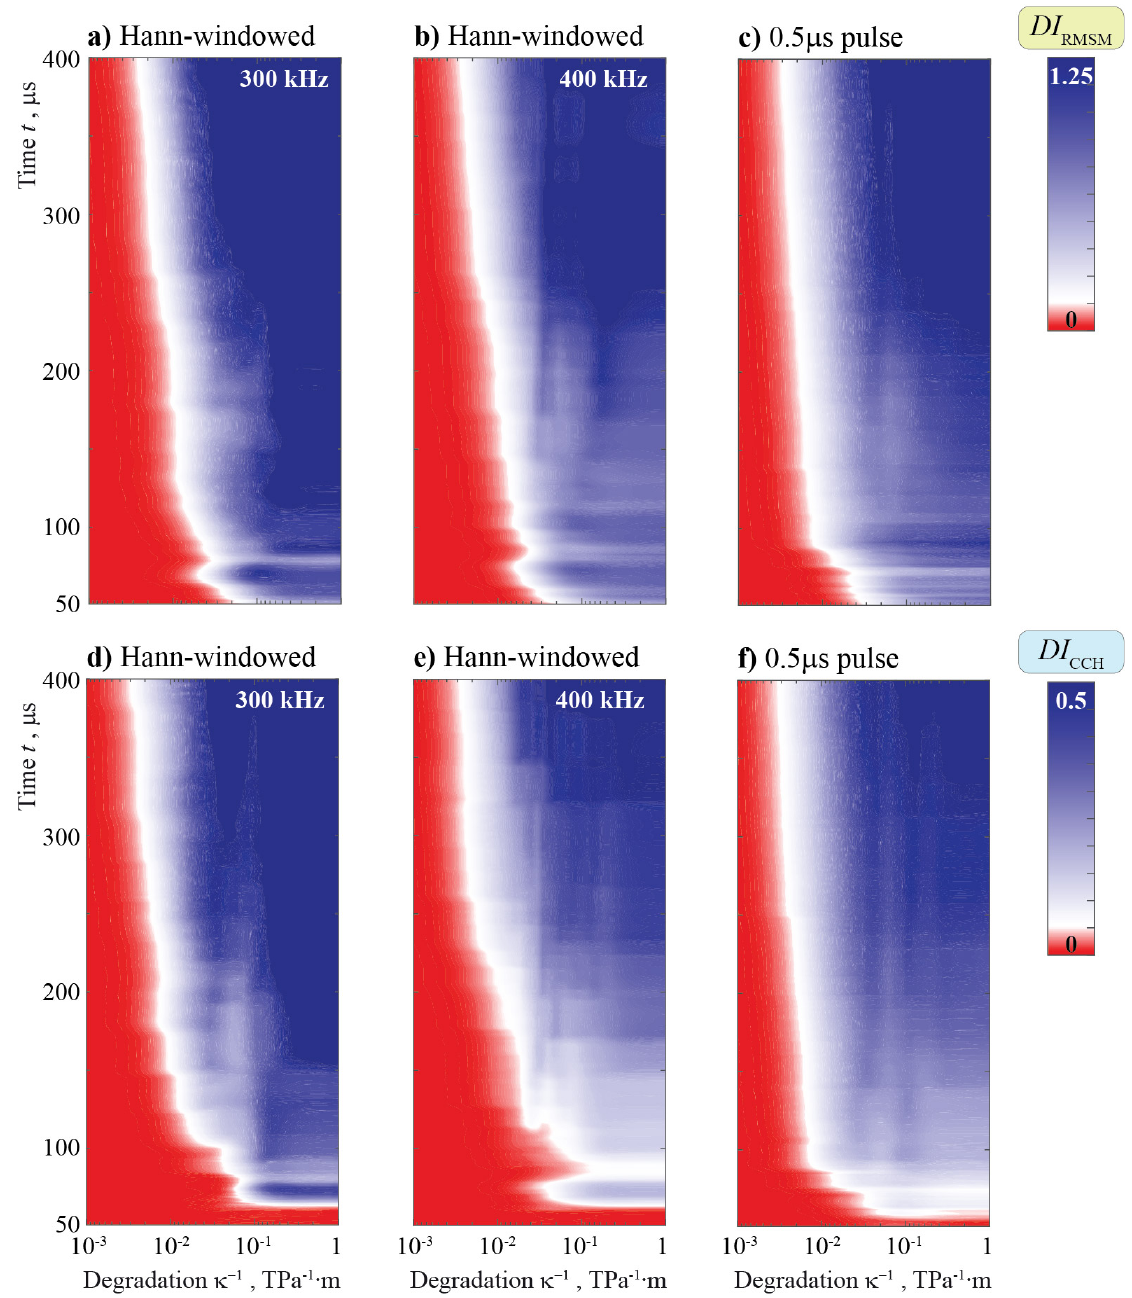
Figure 21. The DI DI m ( κ − 1 , t ) calculated using the data from a sensor at different imperfect contact stiffnesses κ